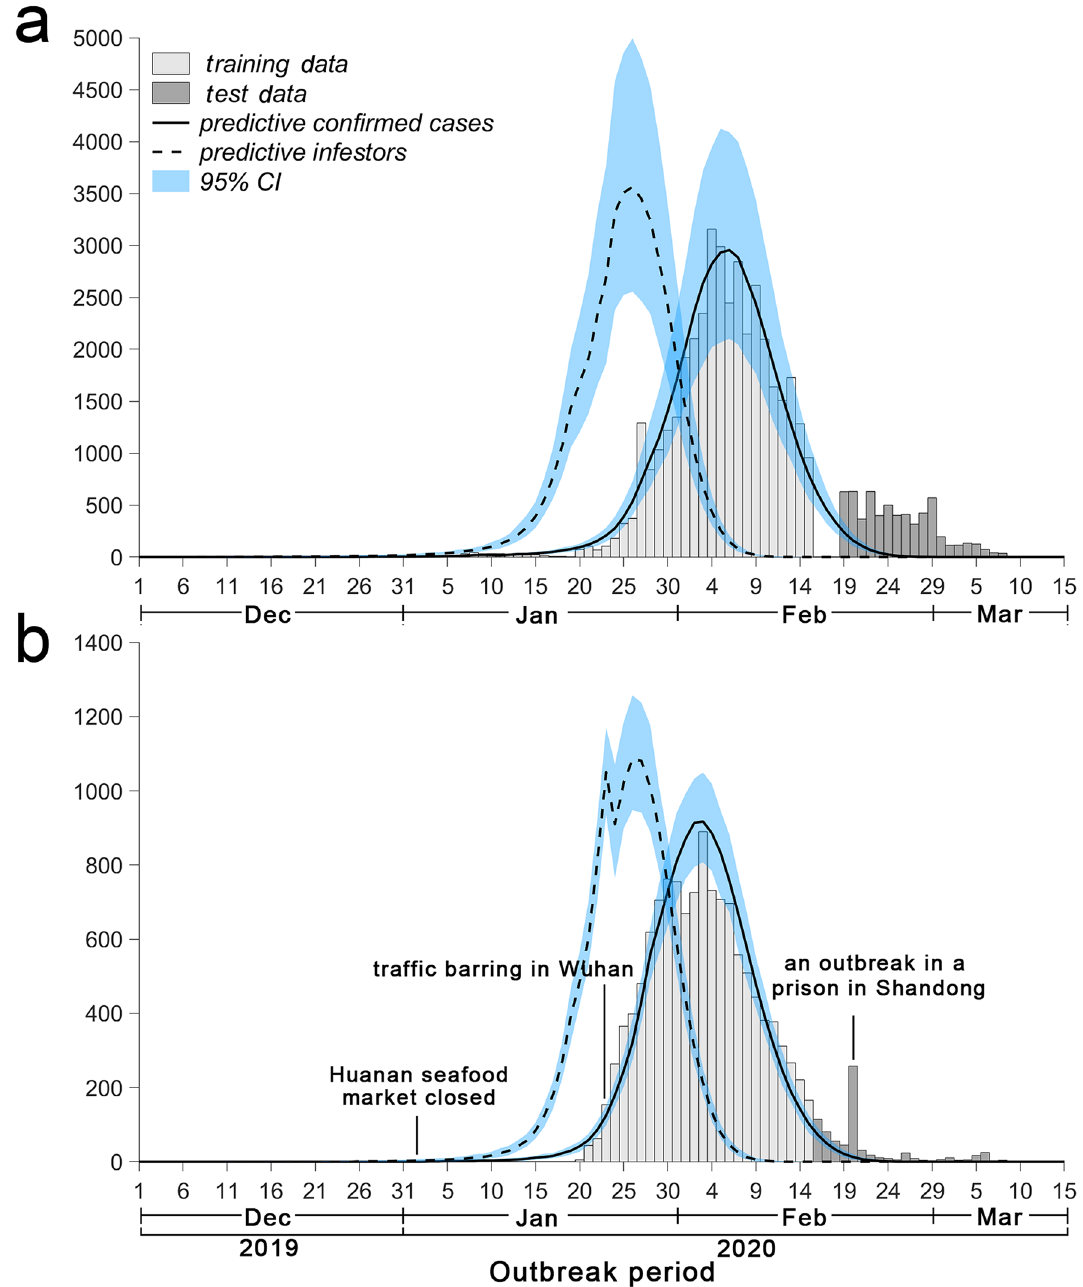
Figure 3. Numbers of new laboratory-confirmed patients and new infectors estimated by the model. Histogram ( a ) represents the number of new laboratory-confirmed patients in Hubei issued by the government, and the solid and dashed lines represent the numbers of new laboratory-confirmed patients and new infectors in Hubei estimated by the model, respectively. From February 16 to 18, the number of new laboratory-confirmed patients in Hubei could not be obtained because the number of new laboratory-confirmed patients and clinically diagnosed patients was simultaneously released by the HHC. Histogram ( b ) represents the number of new laboratory-confirmed patients in other provinces issued by the government. The abrupt rise in this number on February 20 was owing to a clustering epidemic in a prison in Shandong Province 12 . The solid and dashed lines represent the number of new laboratory-confirmed patients and number of new infectors in other provinces estimated by the model,